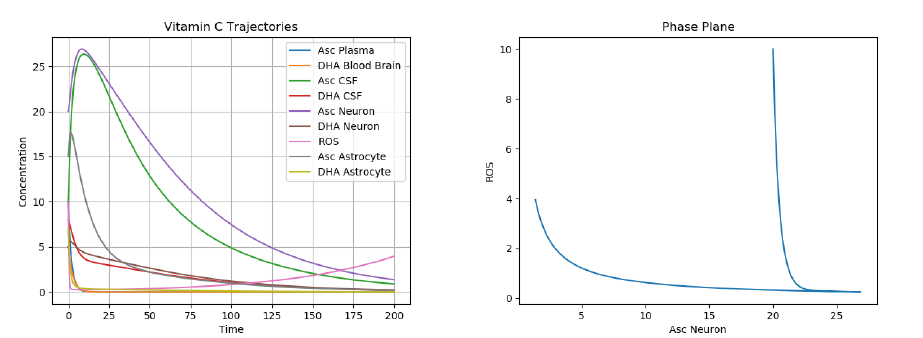
Figure 10. Dynamics of AA, DHA, and ROS in HD